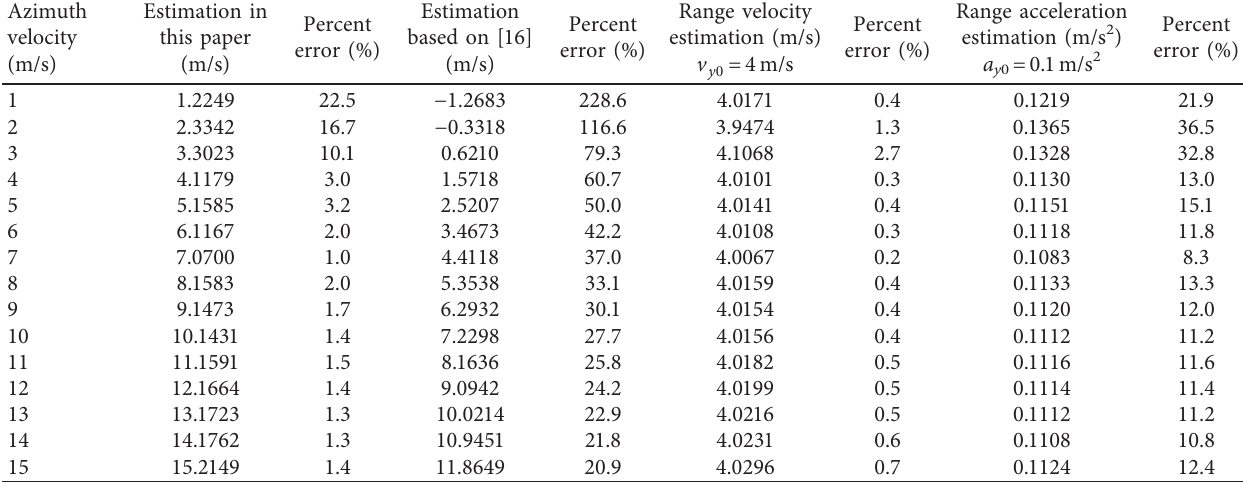
Table 3: Estimation results as a function of azimuth velocity varying from 1m/s to 14 m/s at v Azimuth velocity